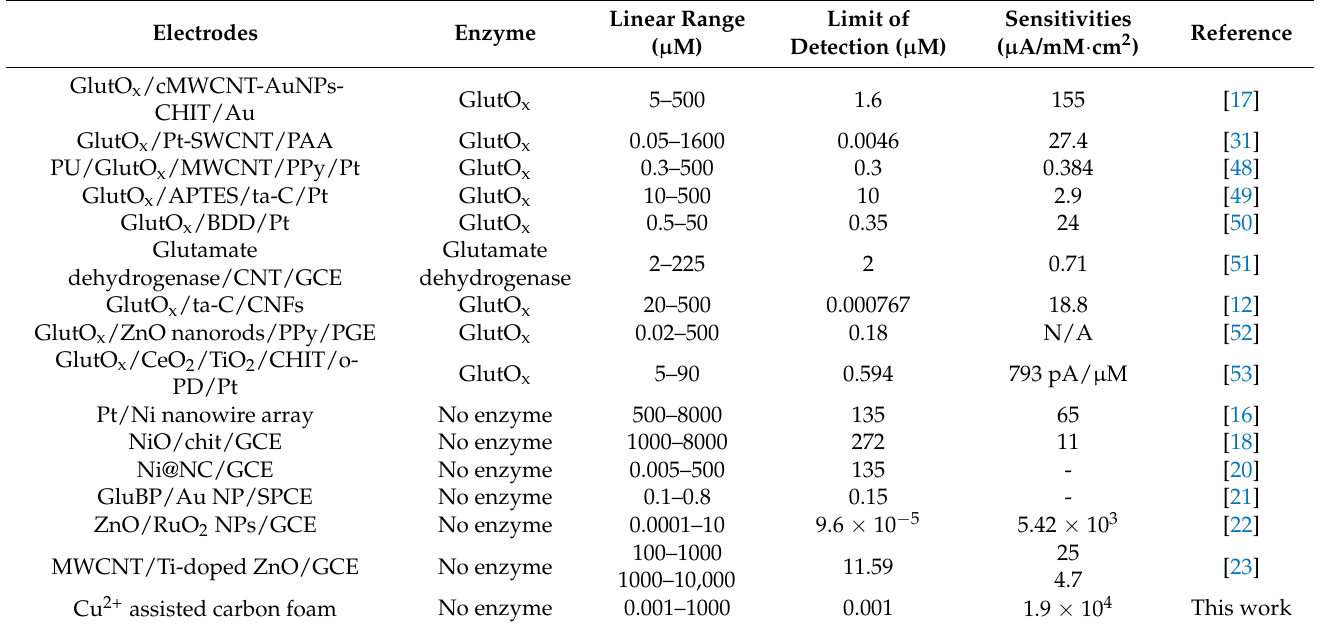
Table 1. Comparison of the performance of different sensor platforms for glutamate